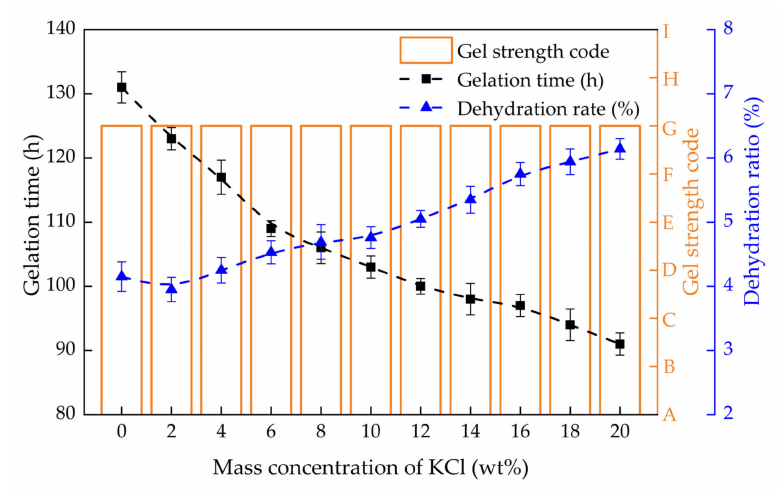
Figure 9. Gelling performance of PHRO in different concentrations of KCl